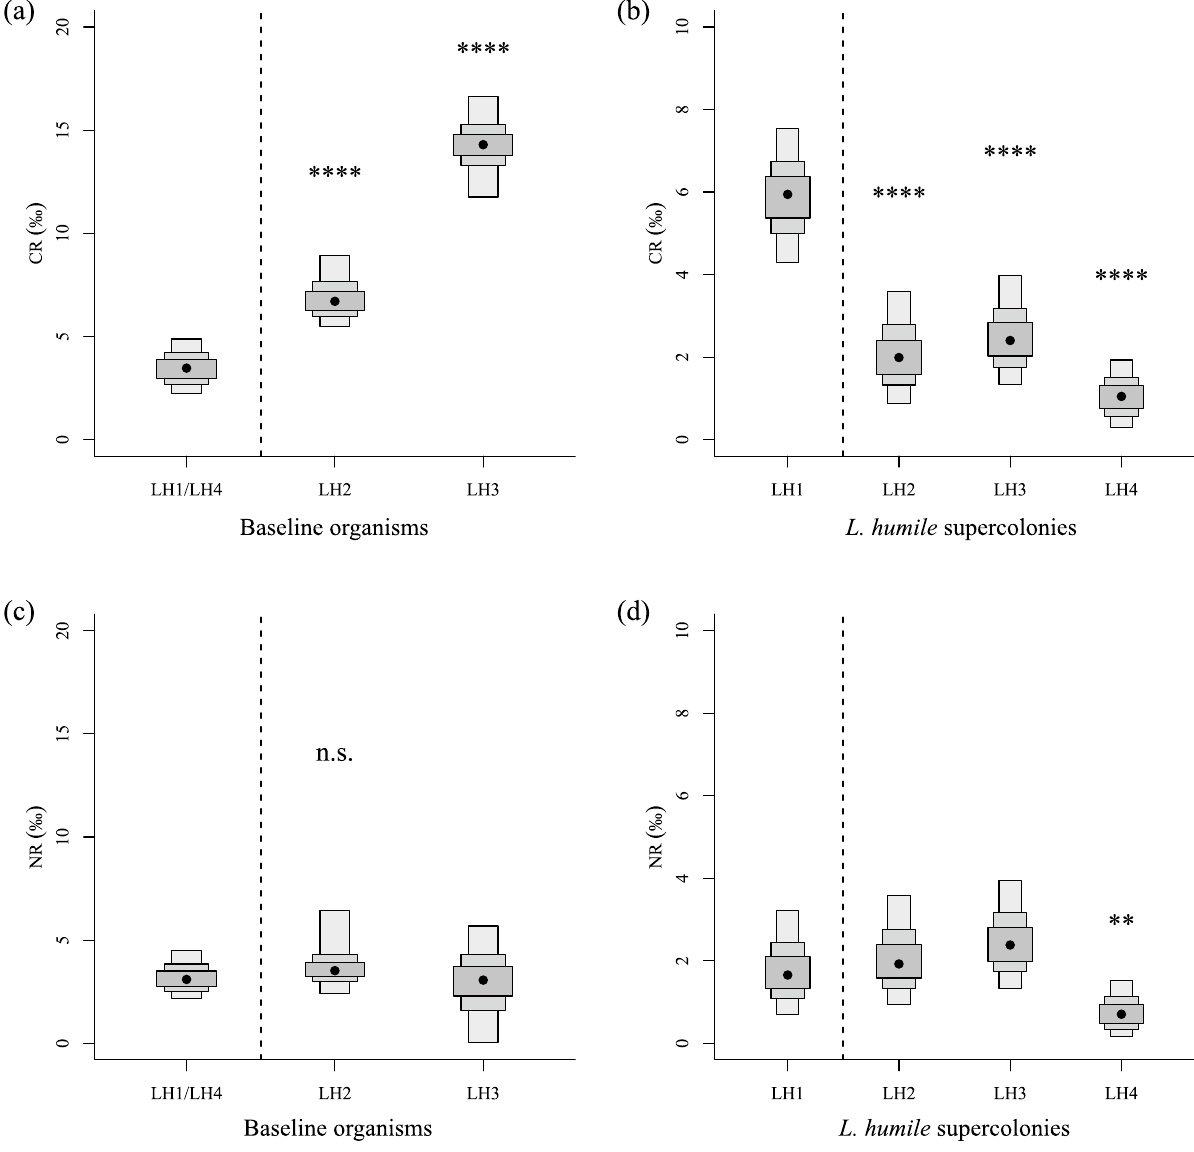
Figure 6. Differences in the range of δ 13 C (CR) among ( a ) baseline organisms collected within the sampling site of each supercolony (LH1/LH4, LH2, and LH3) and among ( b ) the four L. humile supercolonies, with 50%, 75%, and 95% credible intervals (CIs) shown, using the R package “SIBER” 32 . Differences in the range of δ 15 N (NR) among L. humile supercolonies and baseline organisms are shown in ( c ) and ( d ), respectively. Asterisks indicate the significance of the pairwise differences between LH1 and the other supercolonies [*0.6 ≤ P < 0.69, **0.7 ≤ P < 0.79, ***0.8 ≤ P < 0.89, ****0.9 ≤ P ≤ 1; P is the likelihood of a difference between LH1 and the other supercolonies (or LH1/LH4 and the other sampling sites)] 5